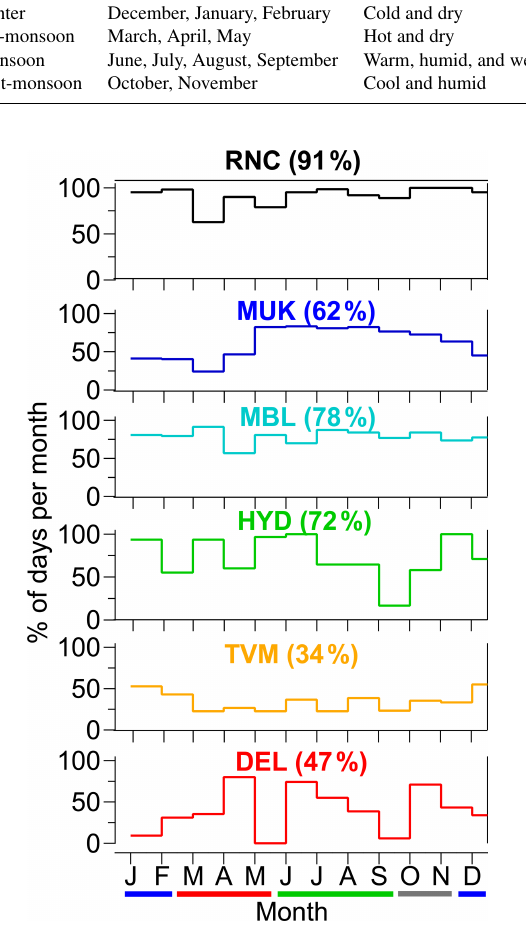
Figure 2. Particle number size distributions data coverage (% of days per month) at the sites. The values in the bracket indicate total data coverage. The thick blue, red, green, and gray lines indicate winter, pre-monsoon, monsoon, and post-monsoon months. Note that measurements are from different time periods for each site (see Table